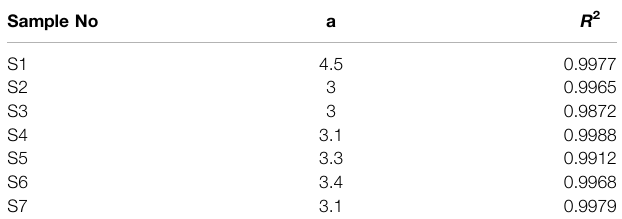
Figure 6A indicates the pore-water pressure ratio ( u versus cycles ( N ) curve under various frequencies. From Figure 6A , the generation law of the u